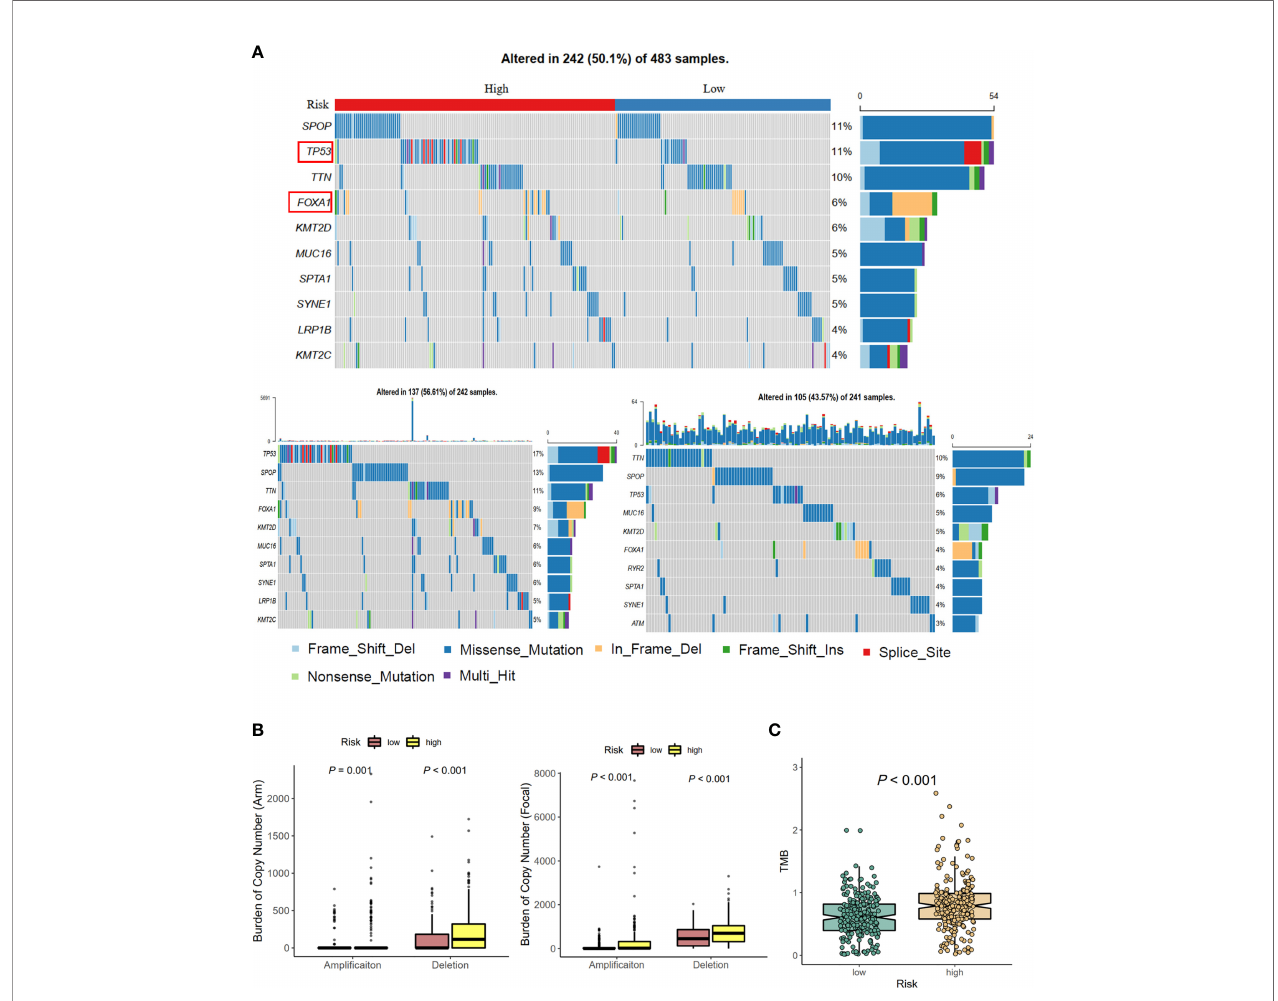
FIGURE 4 | Mutational landscapes between high- and low-risk groups. (A) The distribution of frequently mutated genes in total, high-risk, and low-risk patients. (B) Arm-level, focal-level copy number ampli fi cation and deletion. (C) Tumor mutational burden